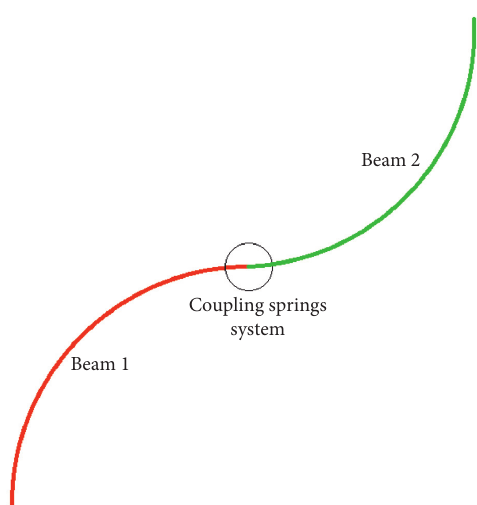
Figure 7: S-type